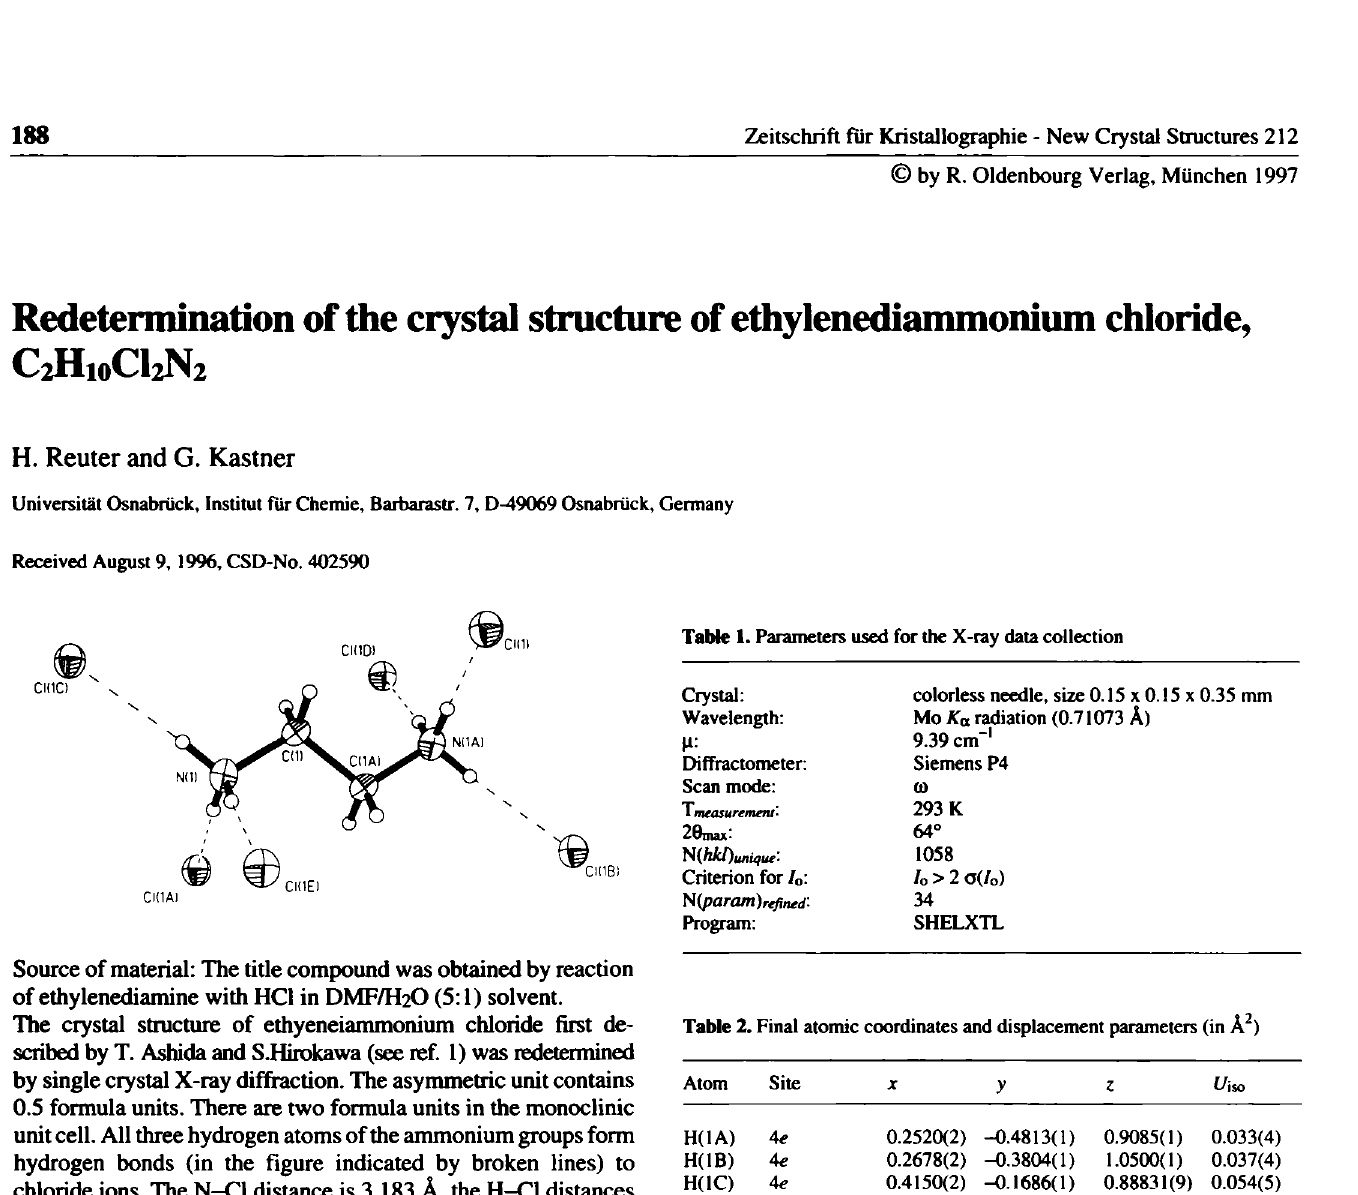
Table 3. Final atomic coordinates and displacement parameters (in Â 2 )